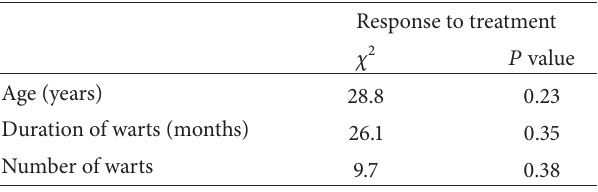
Table 2: Relation between improvement of common warts after intralesional injection of 2% zinc sulfate solution and clinical variables.